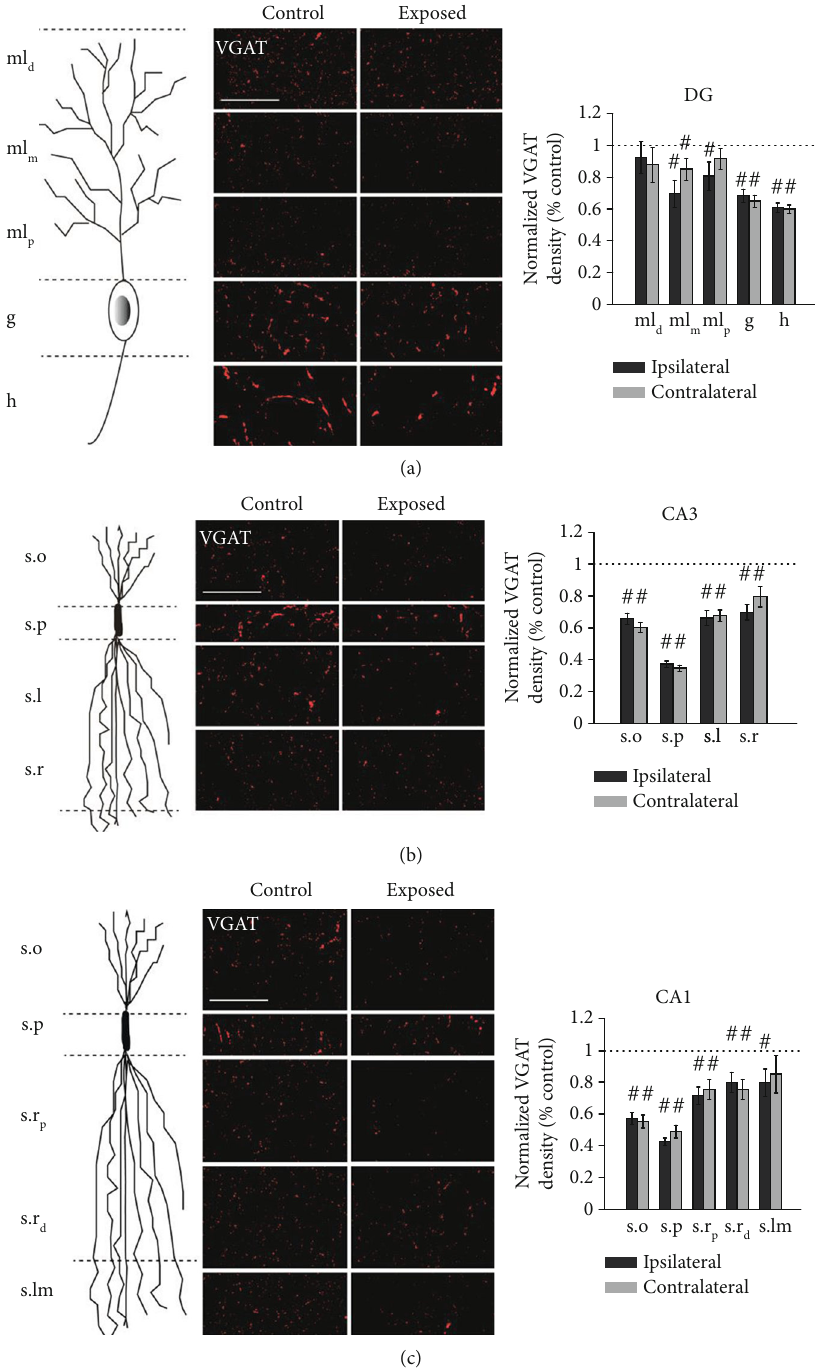
Figure 5: VGAT puncta density decreases in dentate gyrus (DG), area CA3, and area CA1 two weeks following noise exposure. Schematic granule cell in DG (a), pyramidal neuron in CA3 (b), and pyramidal neuron in CA1 (c), depicting organization of inputs corresponding to the layers on the right, which are images of VGAT labeling in CA1 at 400x magni fi cation. Scale bar, 50 μ m. Mean ( ± SEM) VGAT puncta density (per 10 4 μ m 2 ; normalized to respective control) in the dentate gyrus (DG) (a), area CA3 (b), and area CA1 (c) two weeks following noise exposure is shown on respective right panels. # When compared to the controls (dashed line), p ≤ 0 : 05 . ml : distal region of d : middle region of molecular layer; ml : proximal region of molecular layer; g: granule cell layer; h: hilus; s.o: stratum molecular layer; ml m p oriens; s.p: stratum pyramidale; s.l: stratum lucidum; s.r: stratum radiatum; s.r : proximal region of stratum radiatum; s.r : distal region of p d stratum radiatum; s.lm: stratum